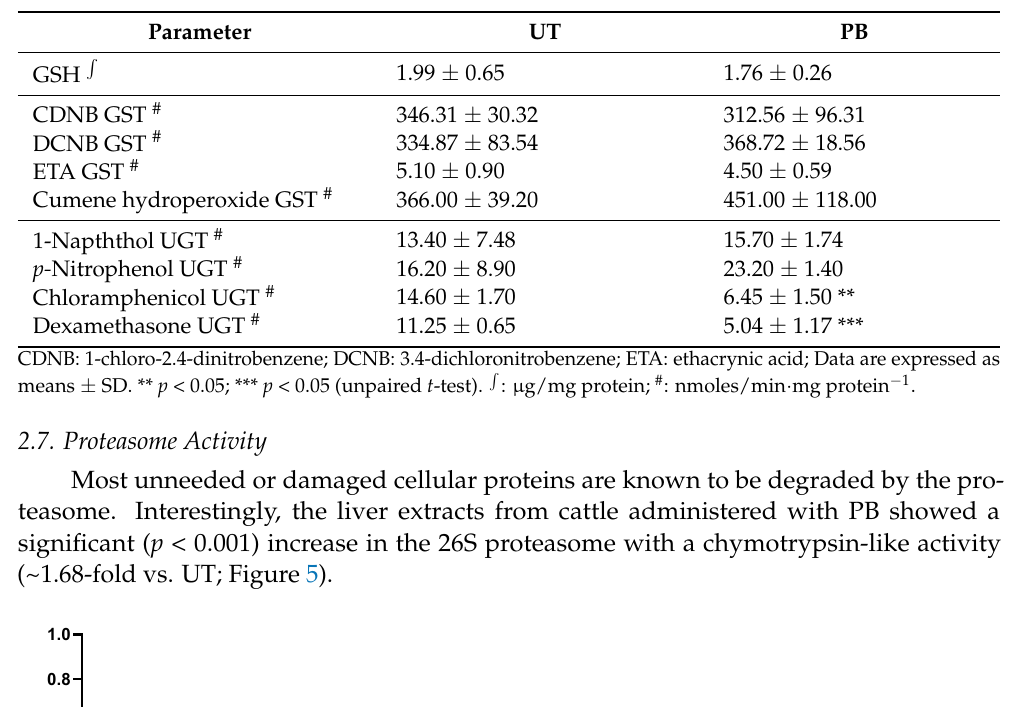
Table 1. Total glutathione (GSH) content, glutathione S -transferase (GST), and UDP-glucuronosyltransferase (UGT) in vitro metabolism in untreated control (UT, n = 3) and phenobarbital-treated (PB, n = 4) cattle.